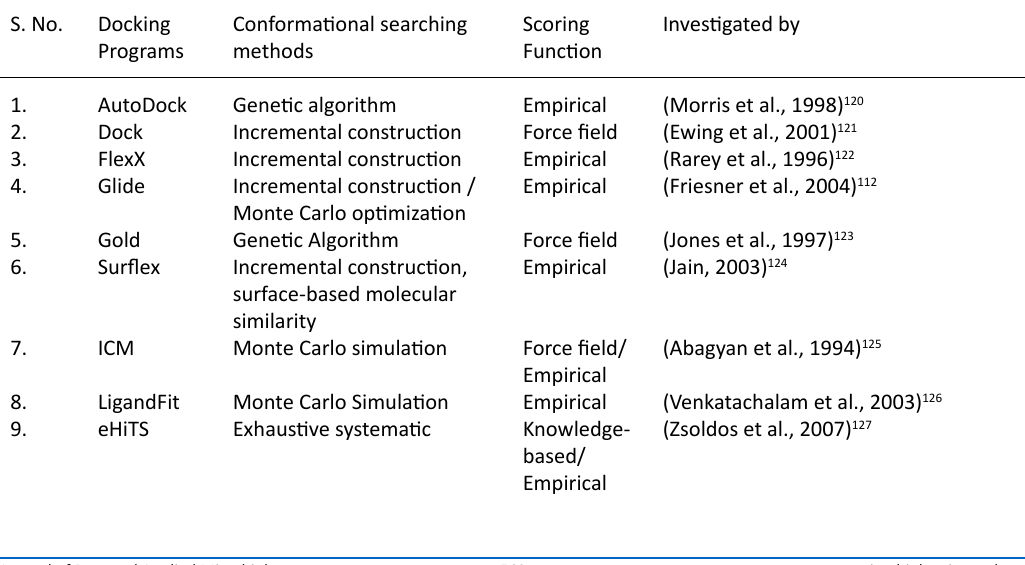
Table 2. List of the protein-ligand docking software S.